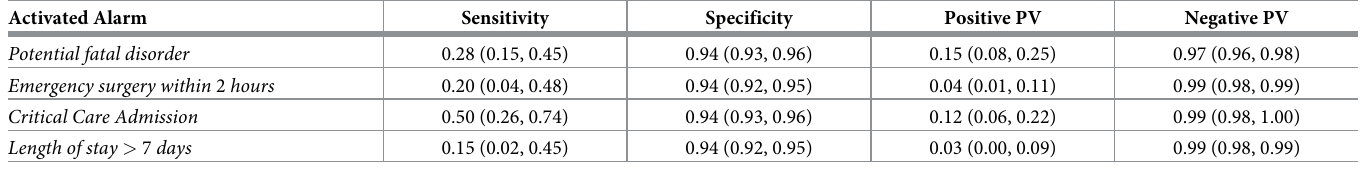
Table 3. Sensitivity, specificity, positive and negative predictive values (with 95% confidence interval) presented by the activation of our MEWS protocol alarm for the detection of PFD and its respective